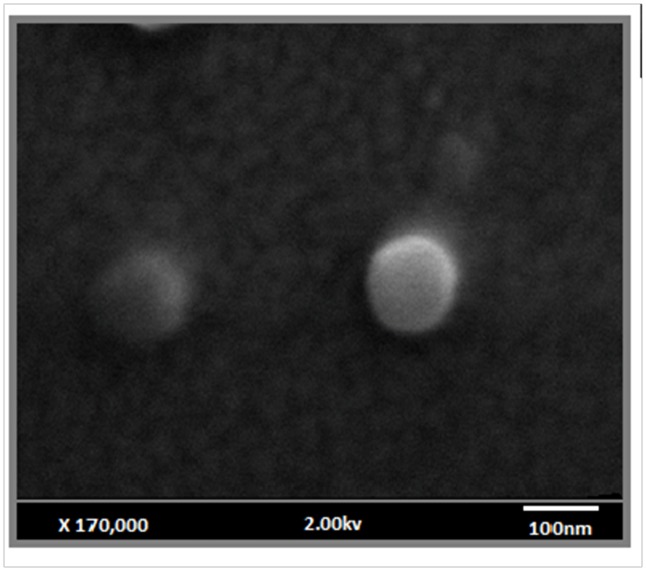
High resolution scanning microscopy images of the NLS loaded with dodecyl (NLS+dodecyl); 170,000× magnification.